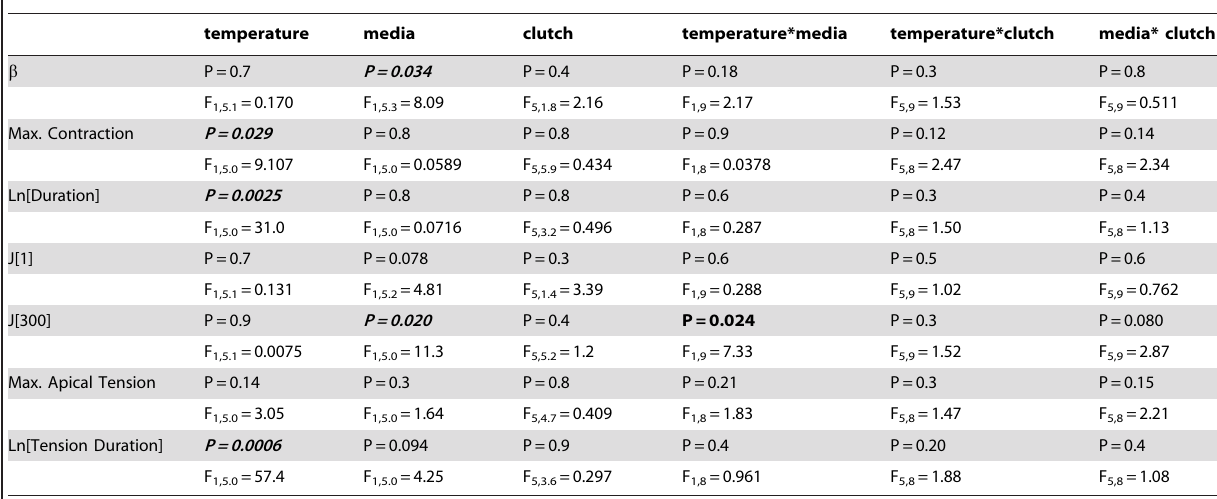
Table 2. ANOVA table for viscoelasticity and contractions.